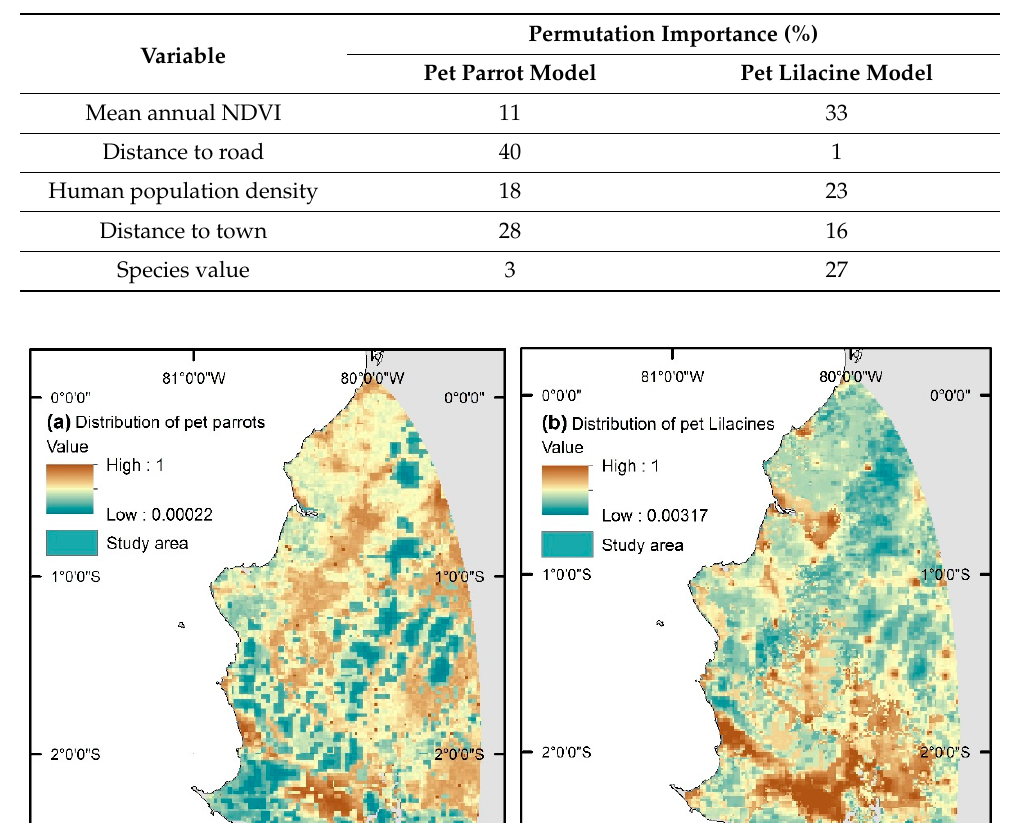
Table 3. Permutation importance values for variables used to create models predicting the distribu- tion of pet parrots and pet Lilacines in coastal Ecuador.